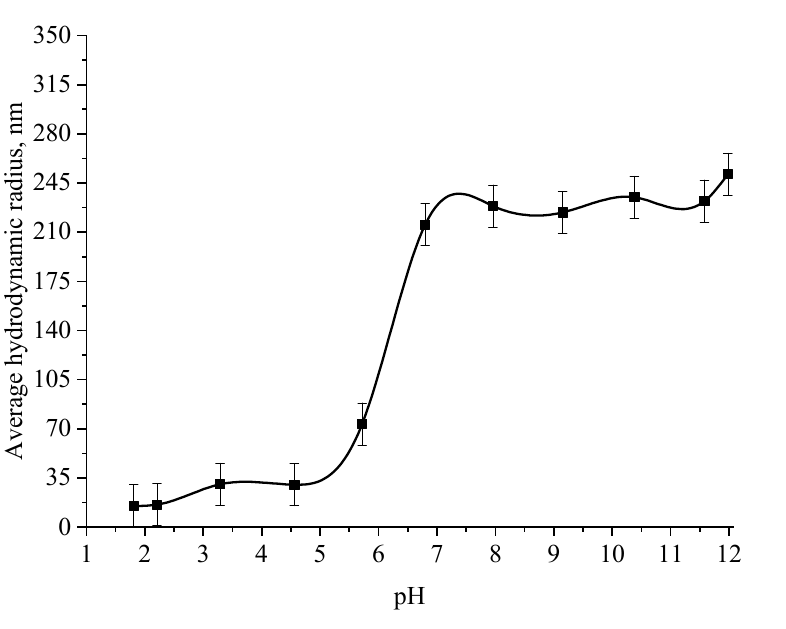
Figure 10. Graph of the dependence of the average hydrodynamic radius of the positive Se NPs sol